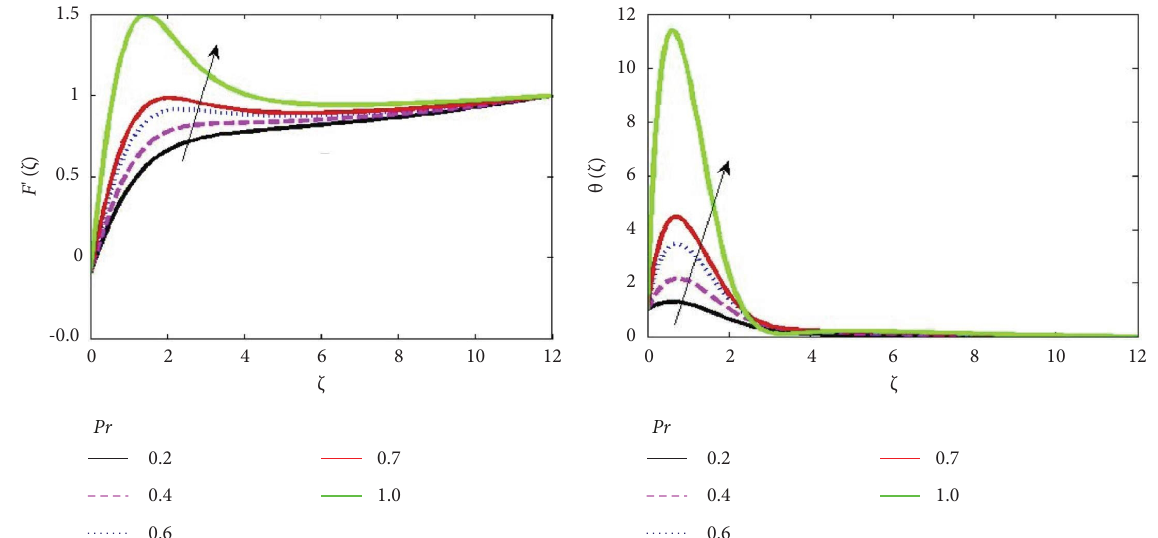
Figure 14: Efect of the Prandtl number on the velocity and temperature